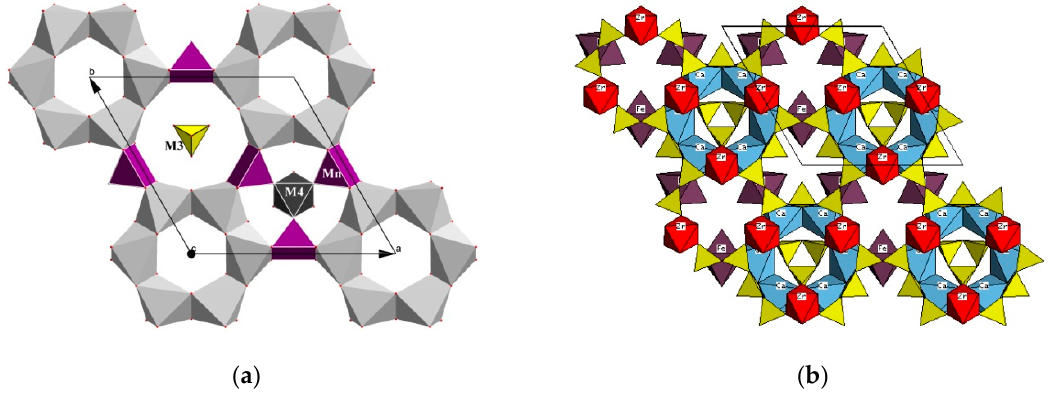
Figure 4. Fragments of the crystal structures of kentbrooksite ( a ) and ikranite ( b ) viewed along (001).